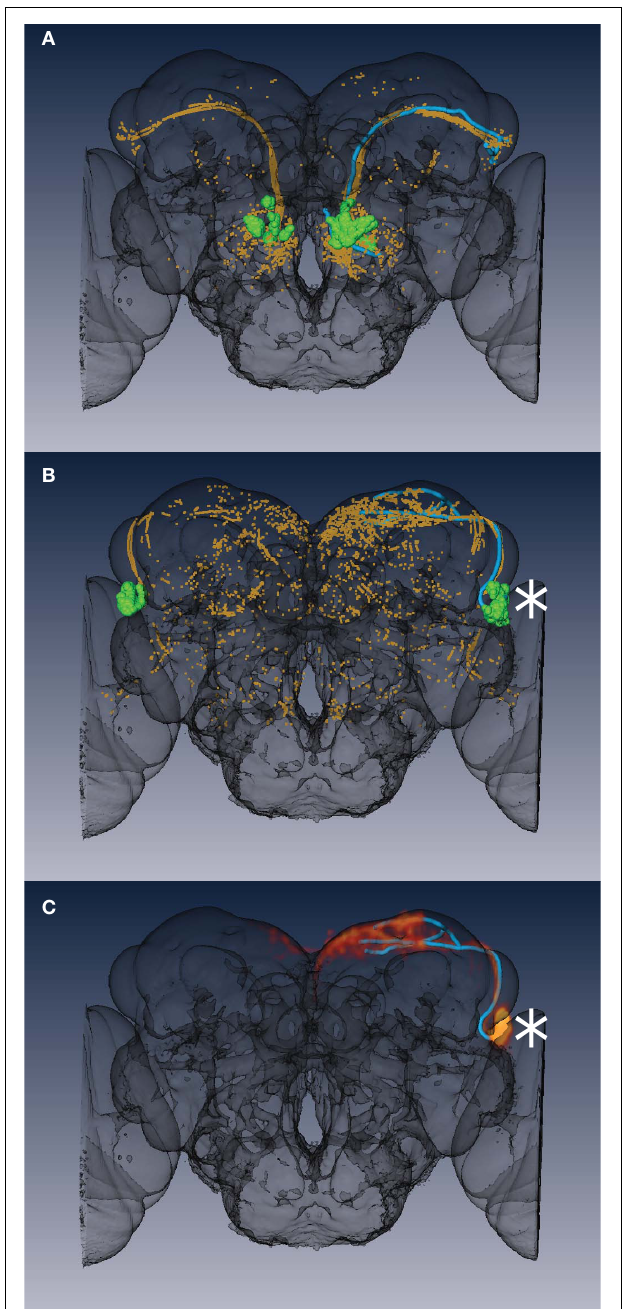
FIGURE 5 | Searching fruitless clone templates using partial tracings. (A) A query tracing (cyan, aDT3 cluster) was used to search the classifier developed in this study.The informative (high mutual information) points from the closest matching template clone are shown in orange, while the cell bodies are shown in green. (B) A similar search was carried out for a second tracing (aSP7 cluster). (C) Volume rendering of an image containing the AL-b neuroblast clone (red/orange) showing the excellent match with the query tracing (cyan). Notice also the excellent correspondence of the position of the cell body cluster (asterisk) with the green template cell bodies in (B) . In both (A,B) informative points (orange) are present on both sides of the brain since the training set has clones in the left and right hemispheres (see Materials and Methods for details of this